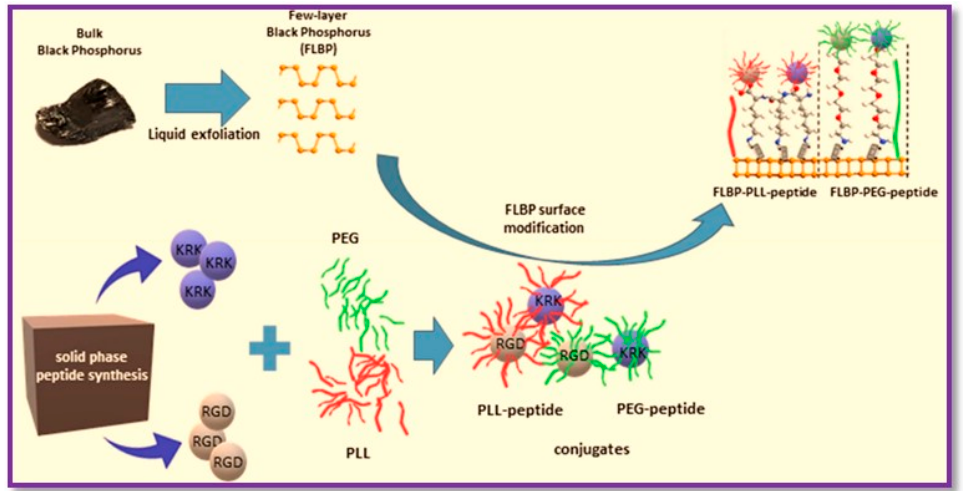
Figure 20. Scheme processes to yield FLBP-linker-peptide conjugates [partially drawn with Quan- tumATK Q-2019.12, Scientific Reports [139], open access article distributed under the terms of the Creative Commons CC BY license, which permits unrestricted use, distribution, and reproduction in any medium, provided the original work is properly cited.